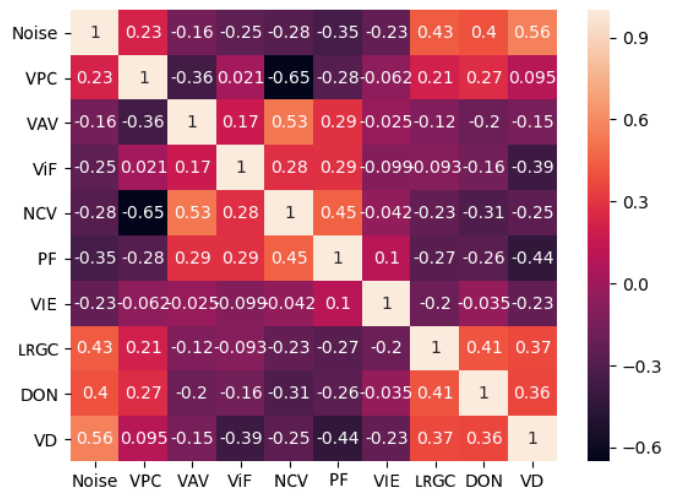
Figure 11. Correlation matrix of the used metrics, together with the dependent variable. For easier visualization the metrics are shown with their coded names— VPC s : vertices seen from parallel camera, VAV s : vertex area visibility, ViF s : vertices in focus, NCV s : number of cameras seeing each vertex, PF s : projected 2D features, VIE m : vertex local color entropy, LRGC m : local roughness from Gaussian curvature, DON m : difference of normals and VD m : vertex local spatial